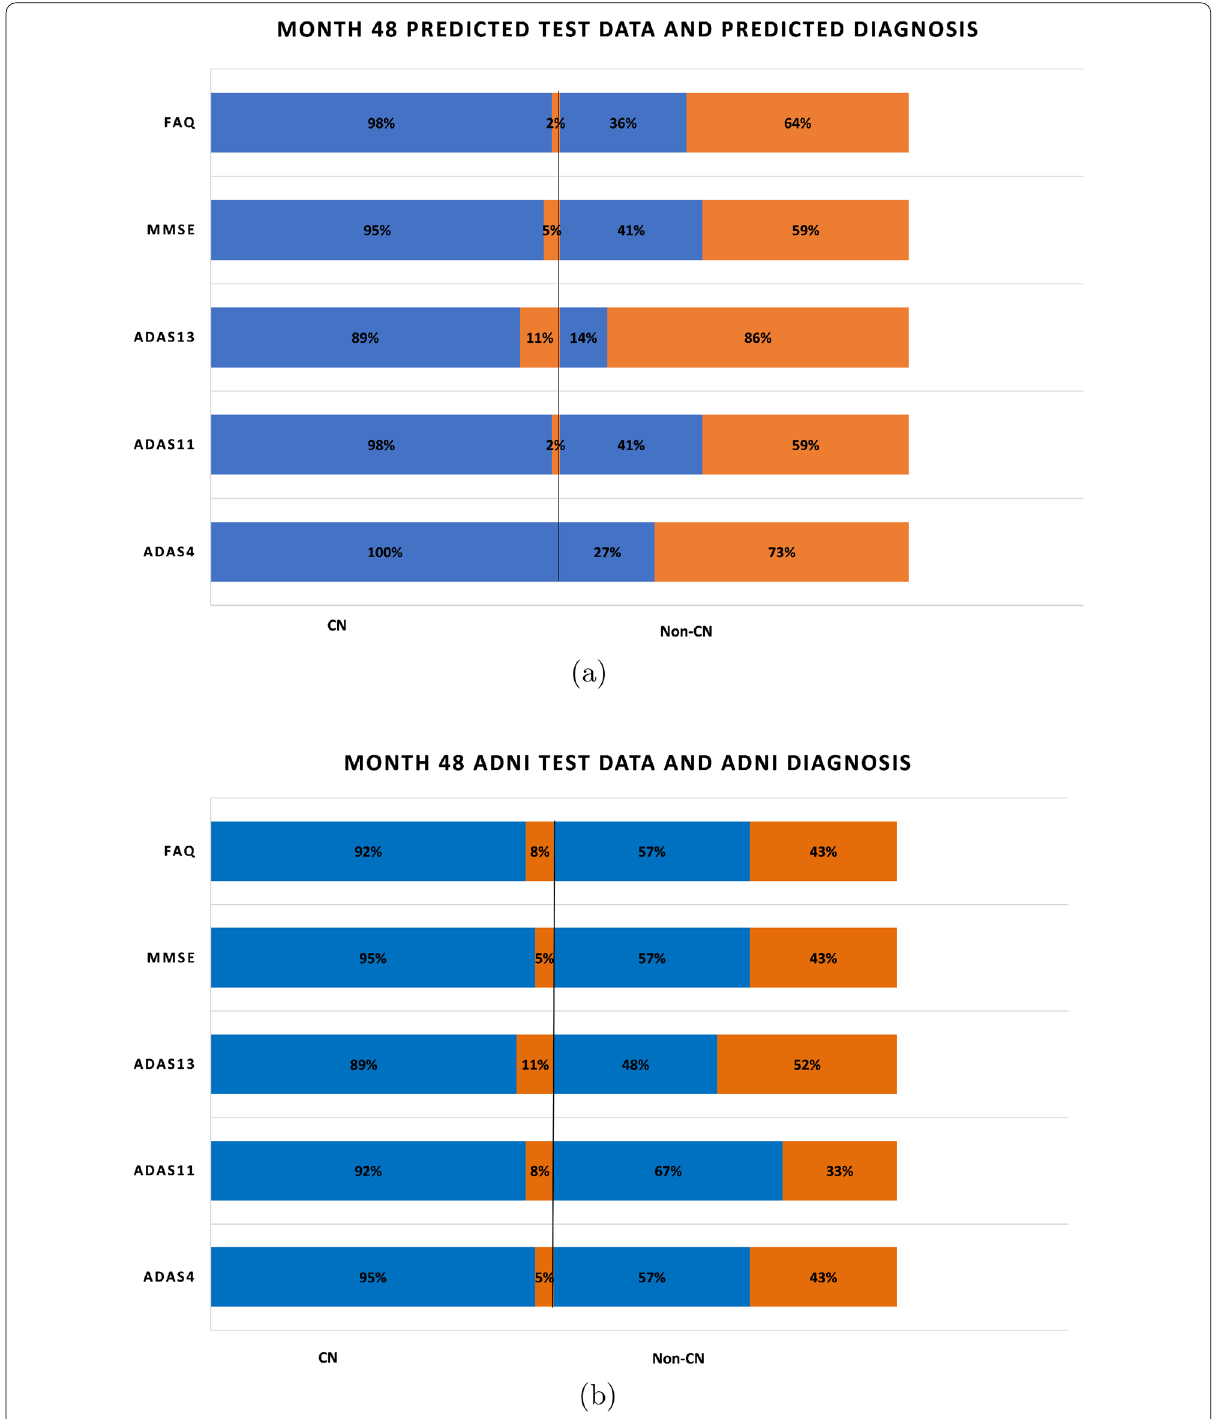
Fig. 15 Proportion of correct and incorrect diagnosis in CN and non-CN categories for test data and predicted test data at month